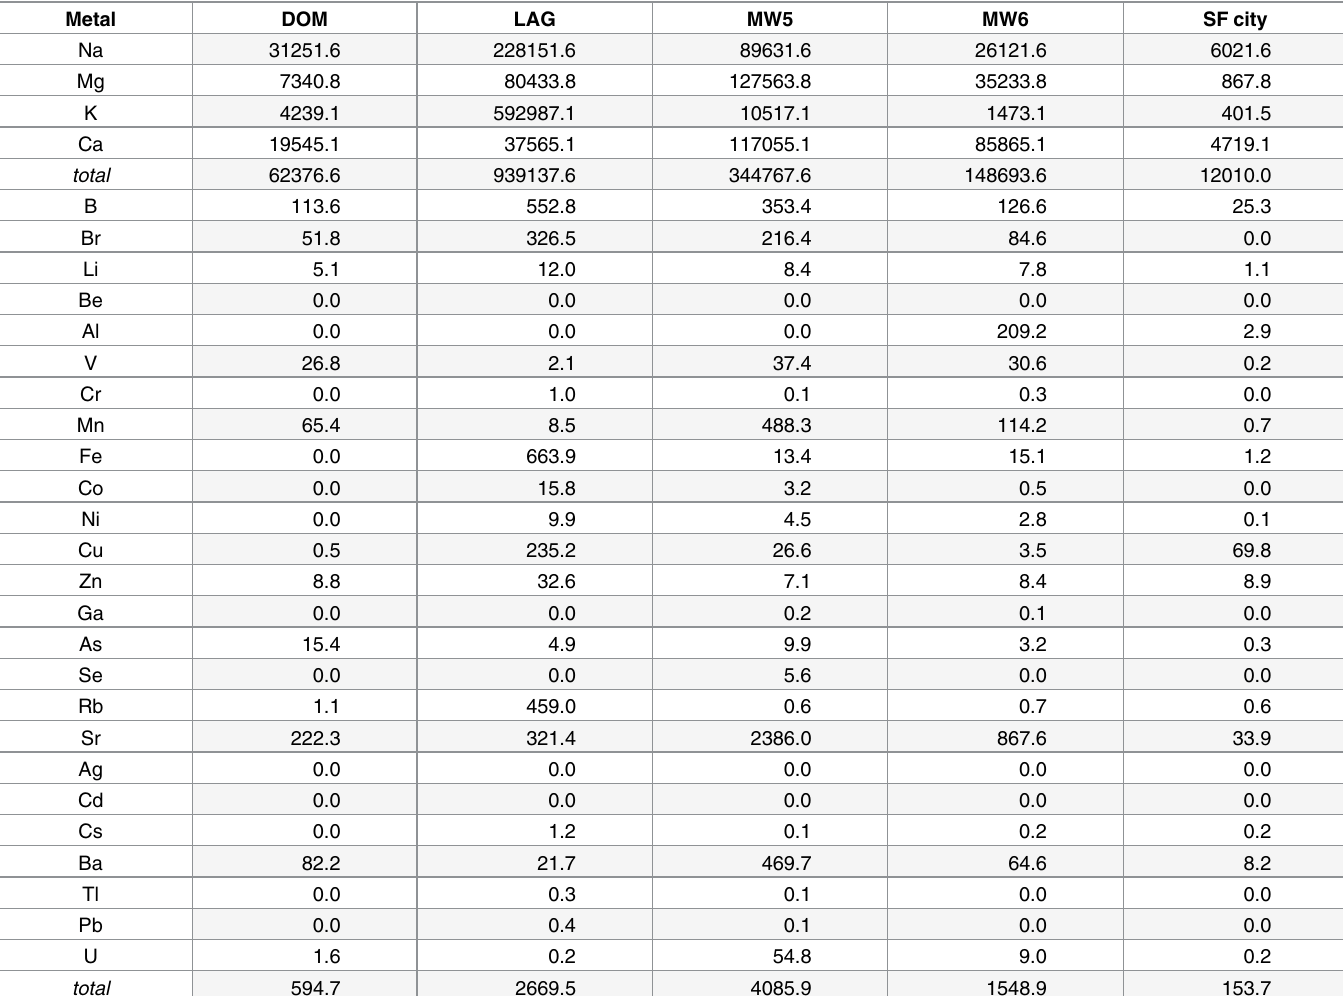
Table 2. Water metals analysis. Metal composition of water samplesby ICP-MS (parts per billion).Statistics availablein S15